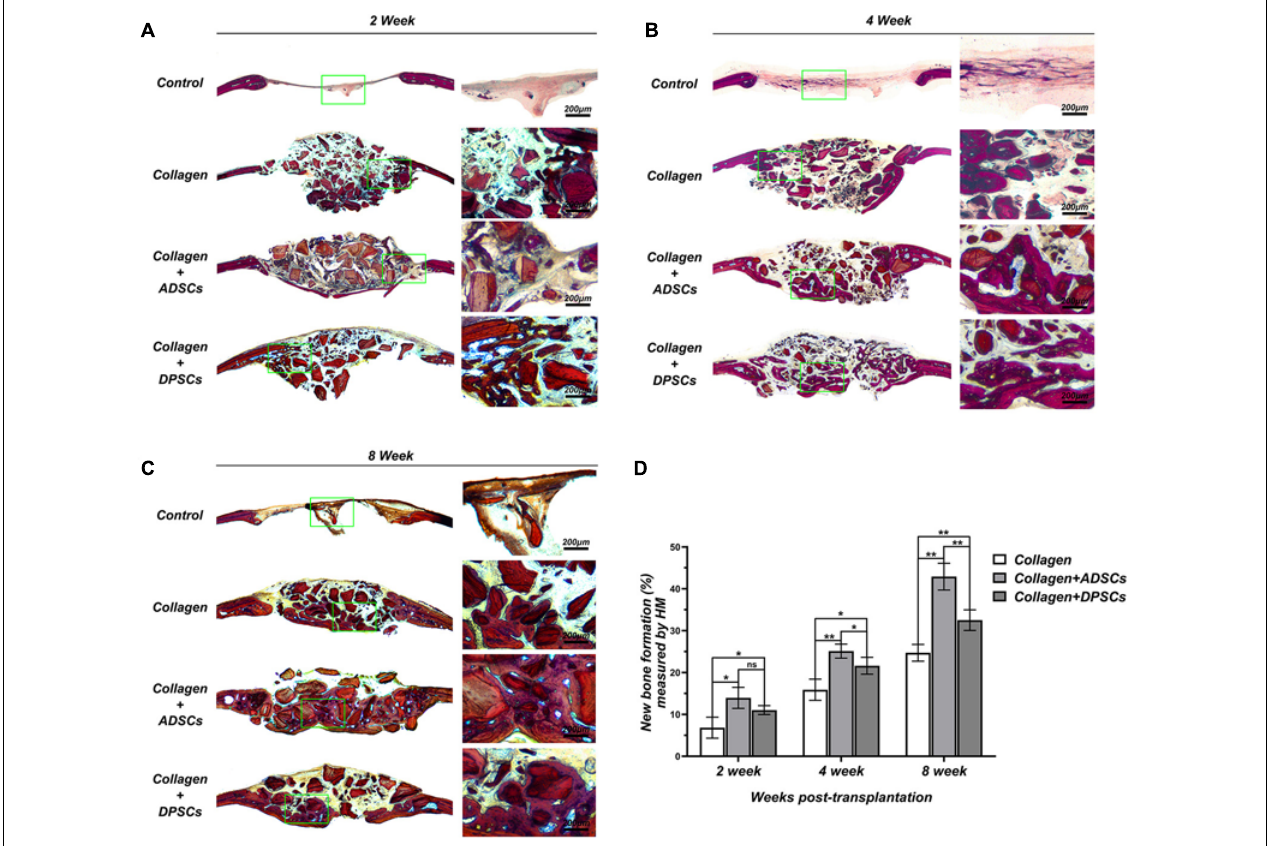
FIGURE 5 | Histological slices in the sagittal plane in the region of interest (ROI) of Control, Bio-Oss Collagen, Bio-Oss Collagen + ADSCs, and Bio-Oss Collagen + DPSCs groups at (A) 2 weeks, (B) 4 weeks, and (C) 8 weeks. Right panels: images of green-bowed area in left panels. (D) Quantitative analysis of the new bone formation by using histological measurement. Data are presented as the mean ± standard deviation, * P < 0.05, ** P < 0.01.